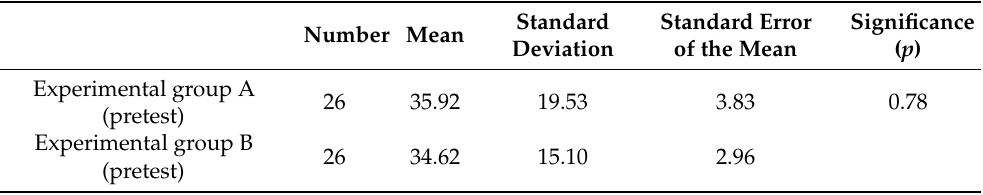
Table 2. Pretest t -test analyses of Experimental group A and Experimental group B.